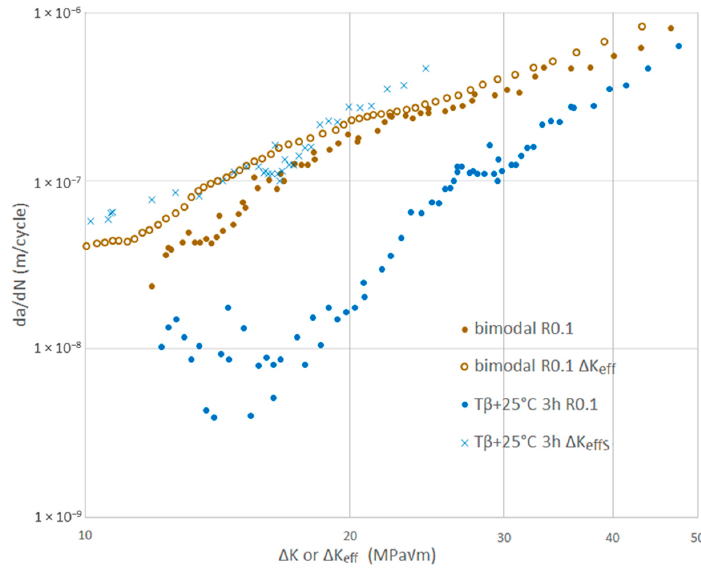
Figure 16. Fatigue crack propagation rates as a function of effective stress intensity range Δ K eff and Δ K effS at R = 0.1 for one lamellar microstructure, compared to the bimodal microstructure.